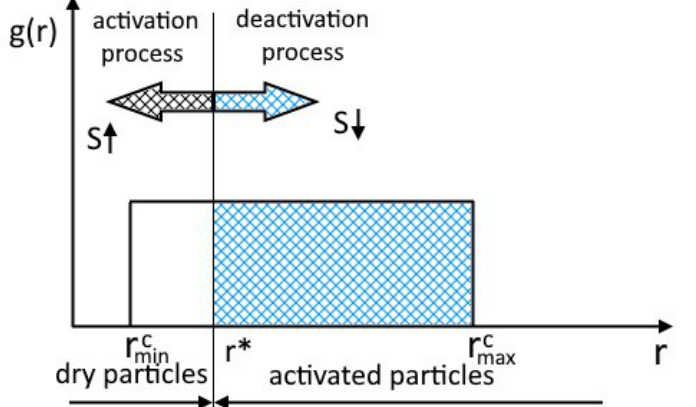
Figure 2. Schematic representation of particle activation, inspired by [26]. To describe the model of homogeneous-heterogeneous condensation, we assume that homogeneous condensation occurs only when the number of formed heterogeneous clusters is insufficient for the medium to pass from a metastable state to a stable one, only due to the formation of heterogeneous